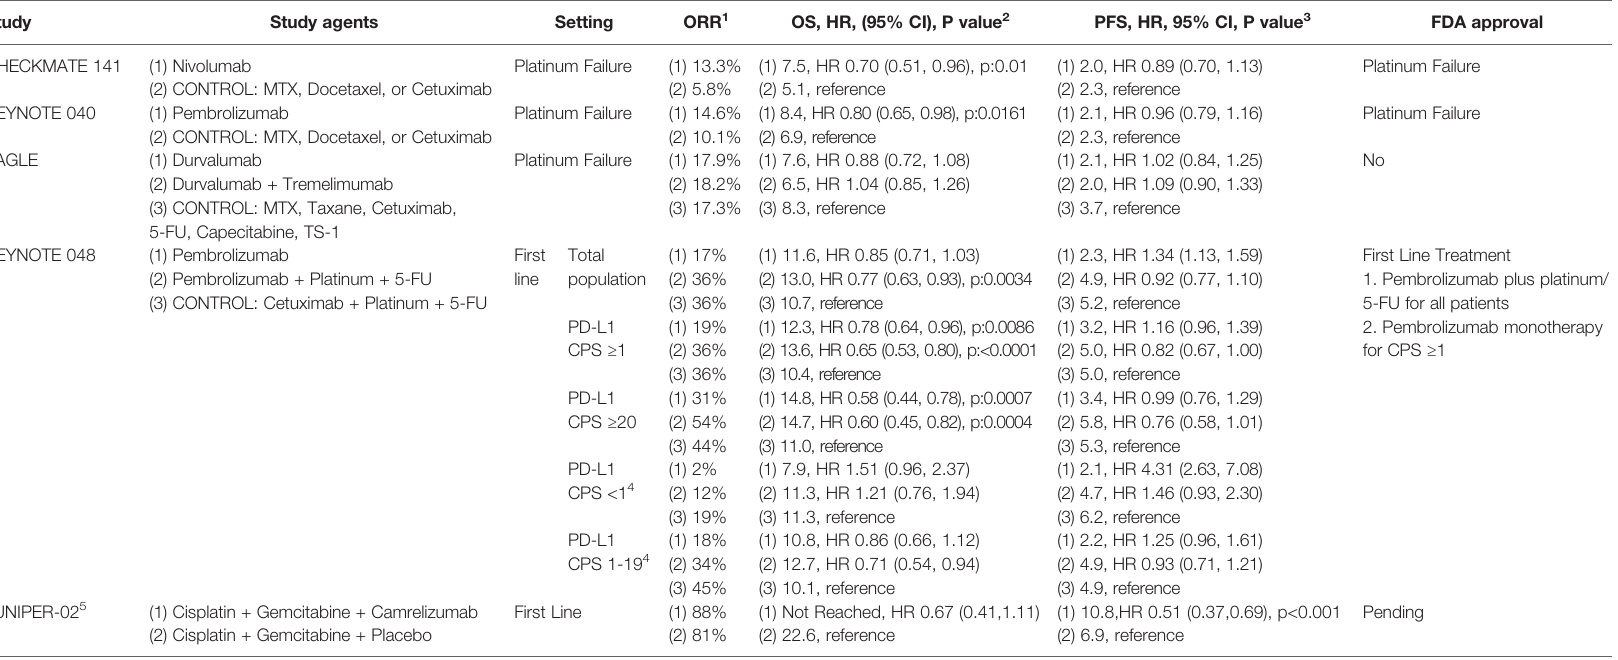
TABLE 1 | Completed Phase III studies of anti-PD-1/PD-L1 mAb therapy in Recurrent/Metastatic